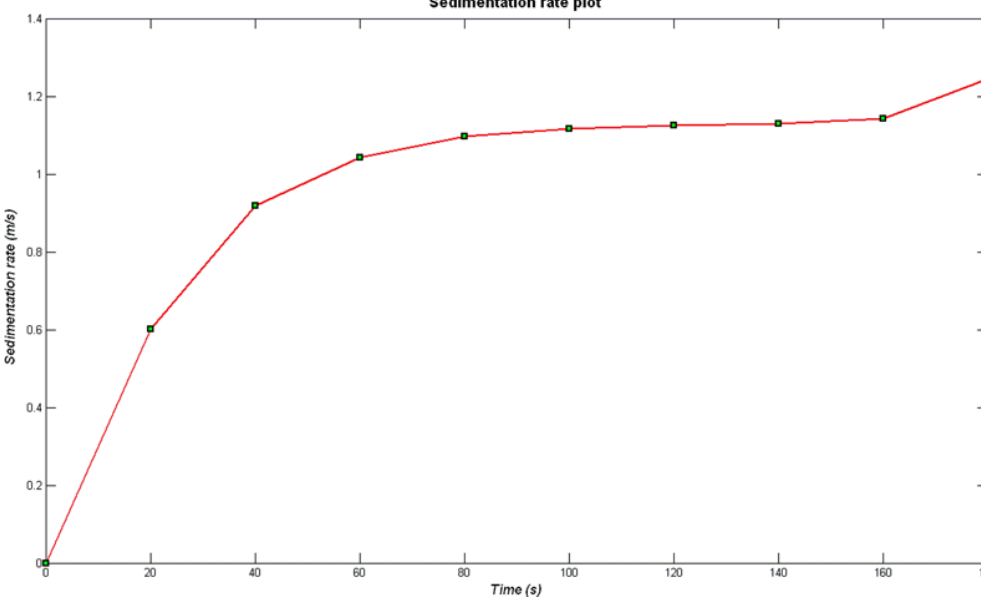
and body attain a maximum height of 850 m. The PDC head, 310 m high, is now the thickest part. This abrupt increase in the height is caused by a large accretion of air ingestion in the last 20 seconds. The plume above the fountain ascends in the atmosphere over the height of 2500